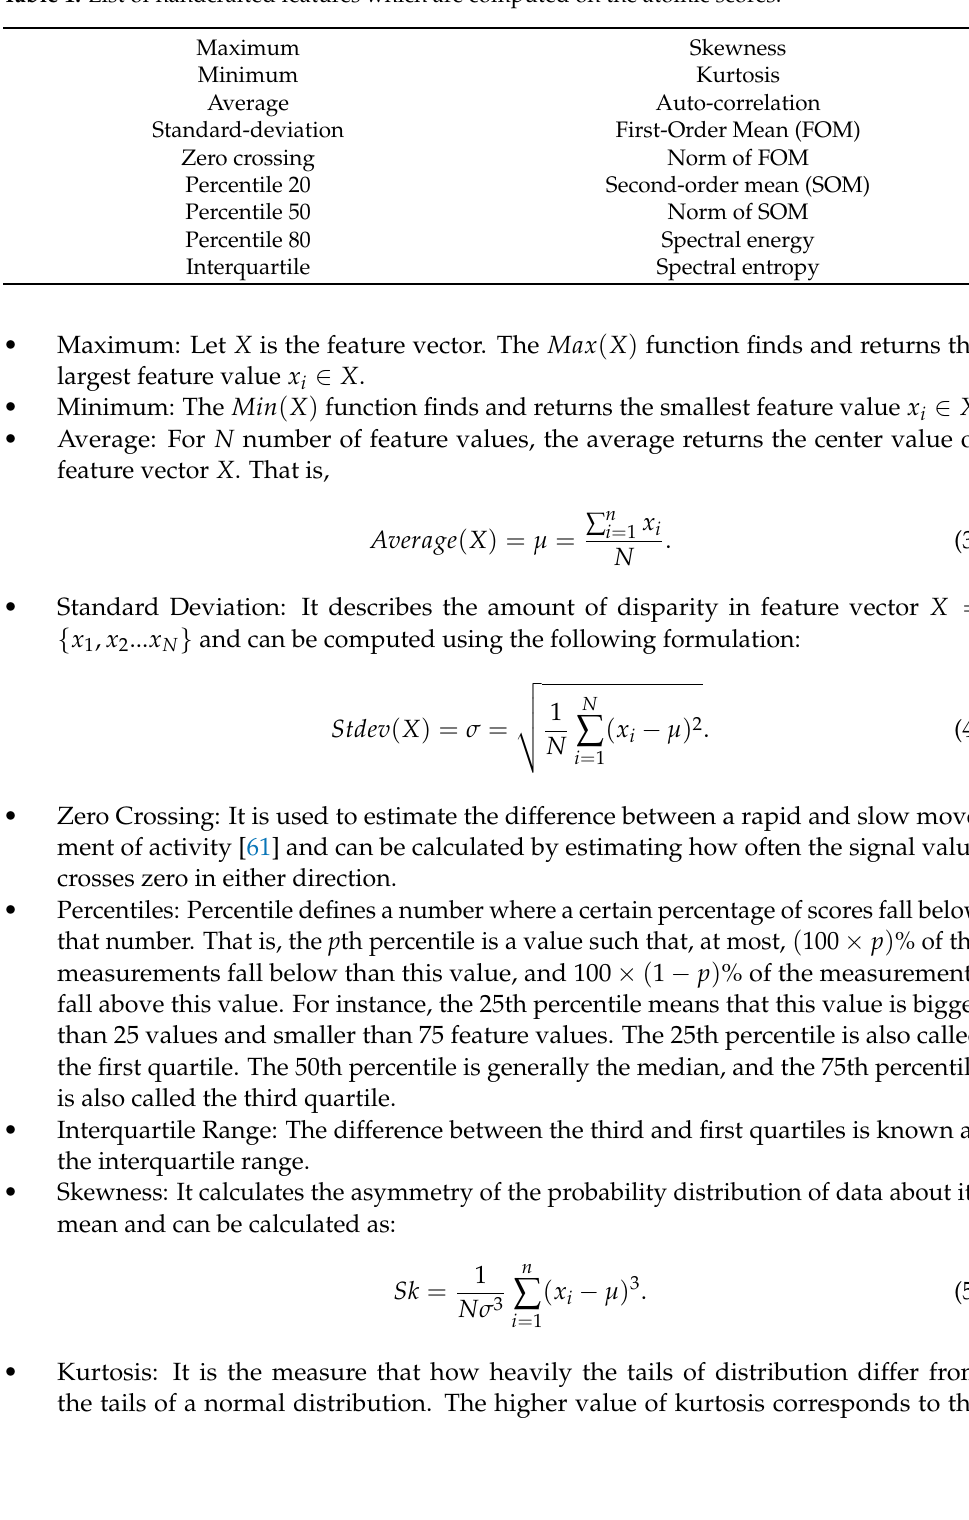
Table 1. List of handcrafted features which are computed on the atomic